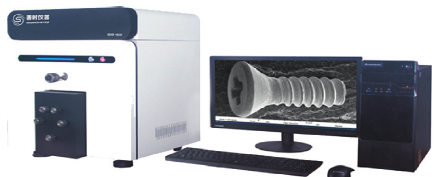
Figure 2: Scanning electron microscope device (SS-150).